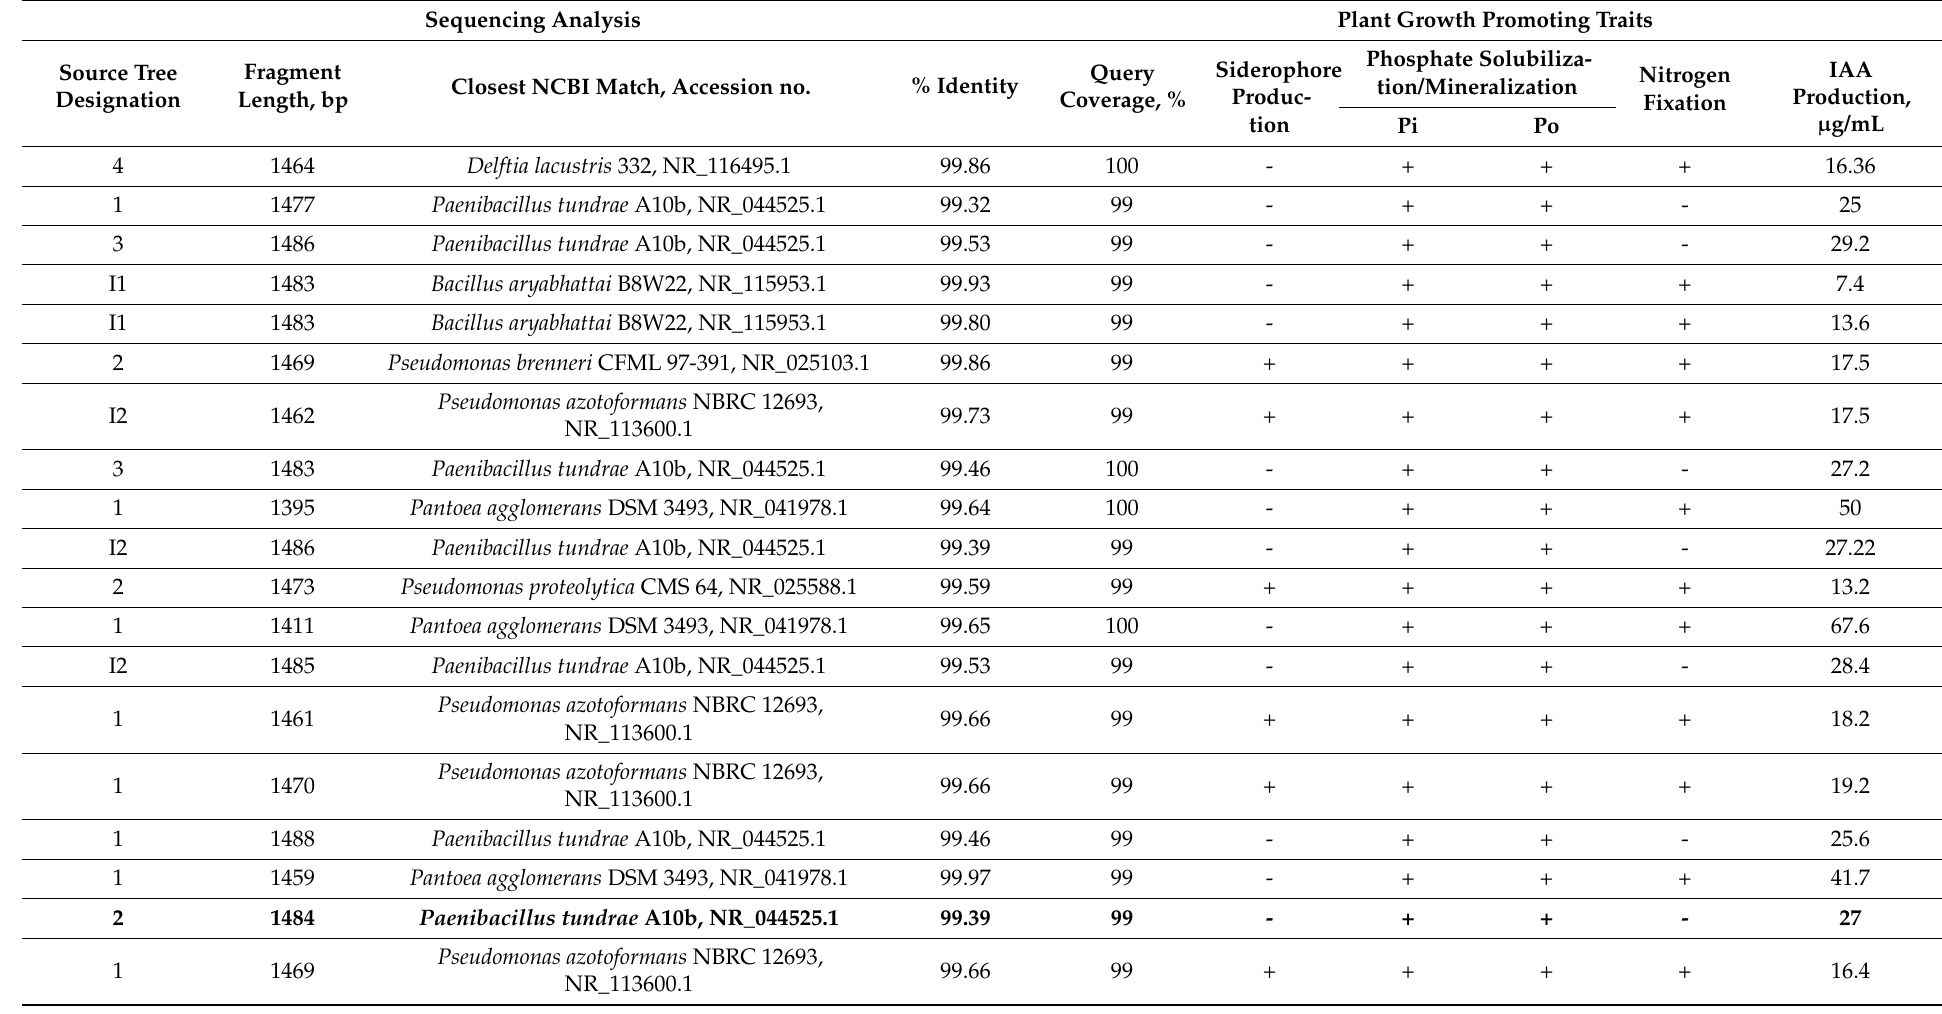
Table 1. Sequence analysis of the 16S rRNA gene and plant growth promoting properties of the 48 bacterial endophytes isolated from Q. robur phyllosphere (highlighted—isolate chosen for further inoculation